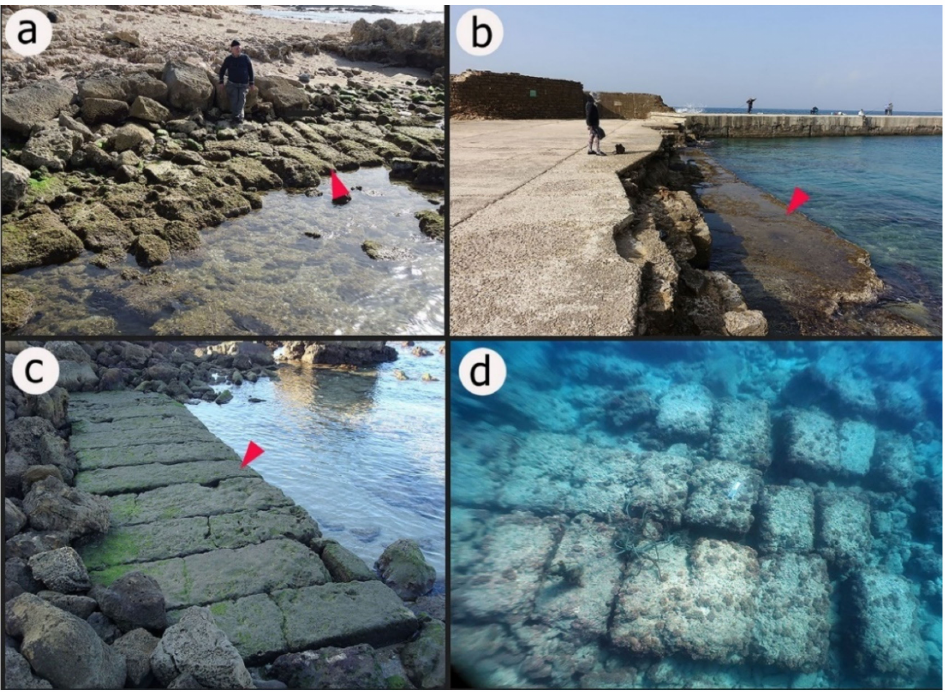
Figure 7. ( a ) The Hellenistic quay at Straton’s Tower at elevation that enables functioning, looking south (for location see Figure 6); ( b ) A Roman quay in the central basin, at an elevation that enables functioning today, looking west (for location see Figure 4 left panel, marked with number (1); ( c ) A Roman quay built of ashlars in the central basin (for location see Figure 4 left panel, marked with number (2); ( d ) A stone-built surface in the western basin, at 5 m below sea level (for location see Figure 4 left panel-marked with number (3).